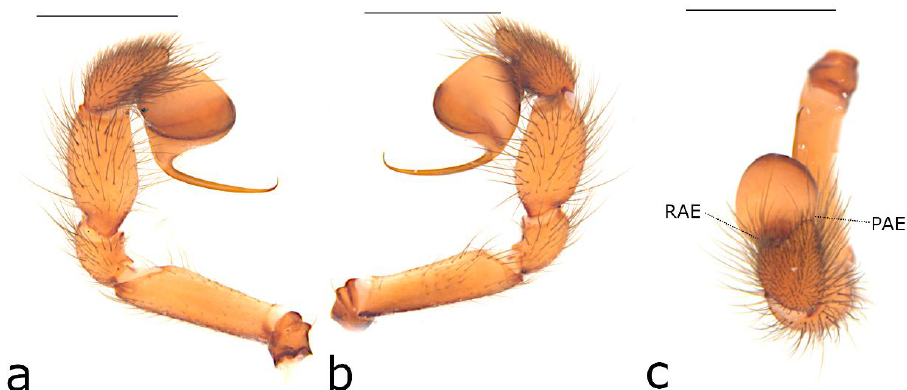
Figure 10. Ariadna spinosa sp. nov. ♂ holotype (SAMA NN22461) from Apoinga (SA): ( a ) left pedipalp, prolateral view; ( b ) same, retrolateral view; ( c ) same, cymbium. Scale bar = 1 mm. Ariadna burchelli (Hogg, 1900) Figure 8; plate 13, figure 4a,b (Hogg 1900) Type material. Holotype The holotype is presumed to be at the MV or the NHM, Lon- don, where much of Hogg’ s material was deposited, but could not be located at either institution for this project (S. Hinkley, J. Beccaloni, pers. comm. to JRM).